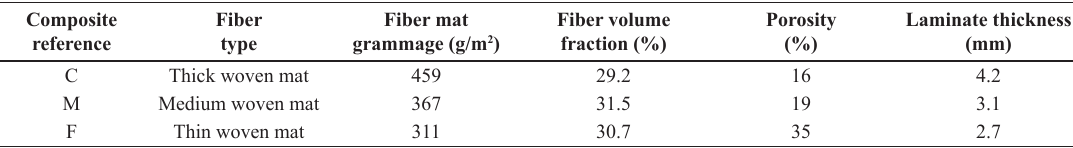
Table 1. Manufacturing